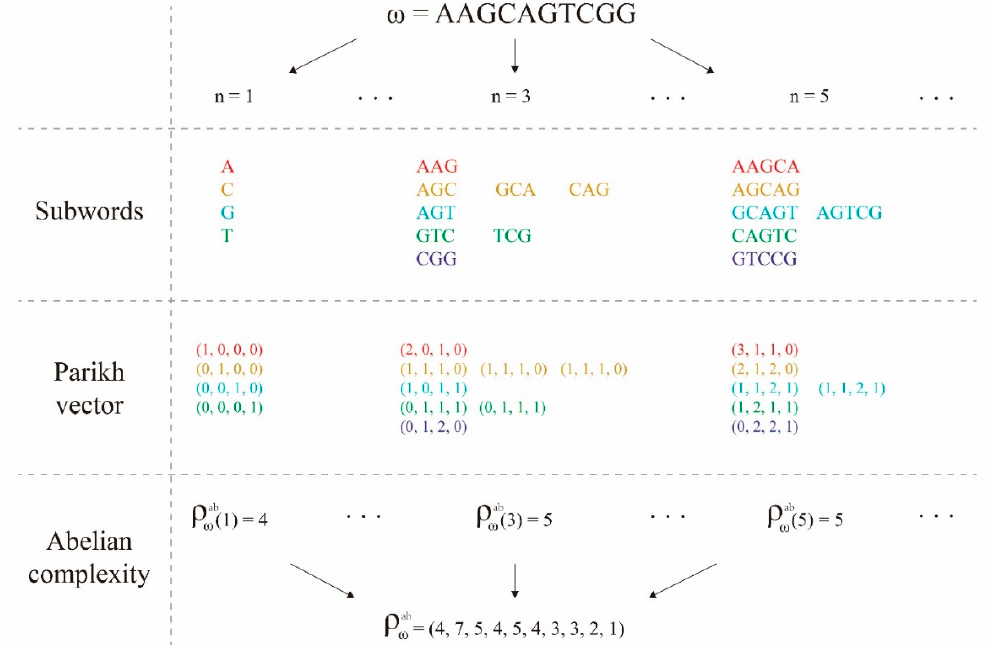
Figure 3. An example for showing the computational algorithm of abelian complexity function.